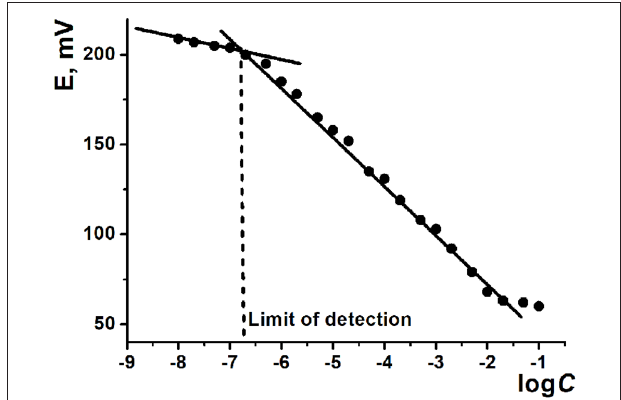
FIGURE 6 | Determination of the limit of detection using calibration curve of Na 2 HPO 4 determination with potentiometric sensor based on MWCNTs support and IL 1 .